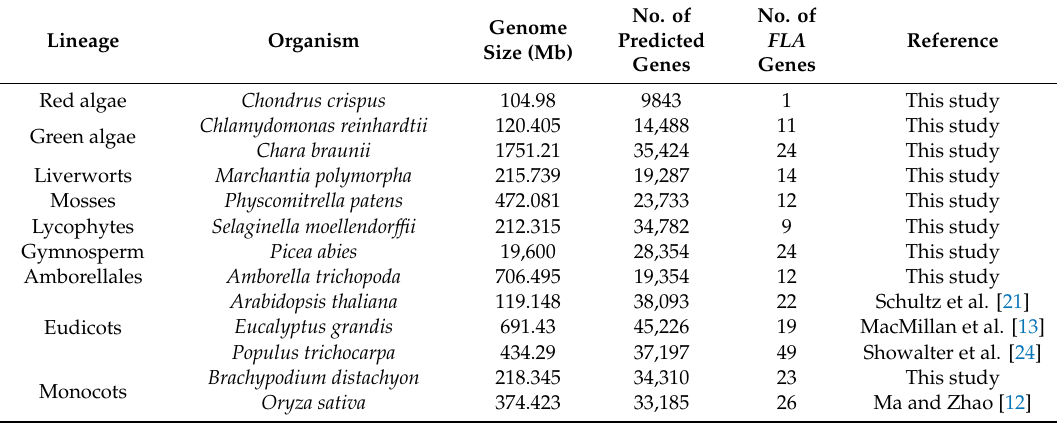
Table 1. Information about genome size and fasciclin-like arabinogalactan protein (FLA) gene number in the plants of interest for this